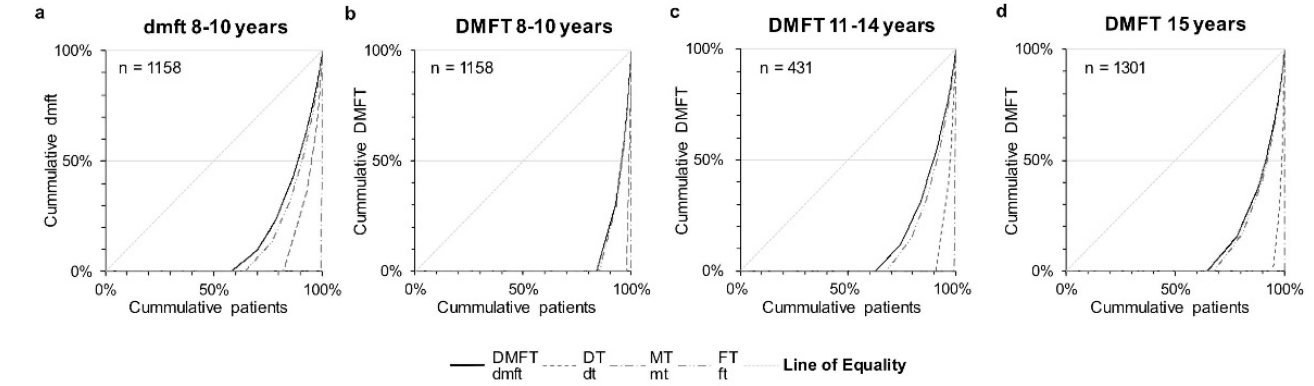
Figure 2. Lorenz curves of the dmft/DMFT values and their components of ( a , b ) 10-year-olds (N = 1158), ( c ) 12-year-olds (N = 431), and ( d ) 15-year-olds (N = 1301). The grey lines indicate the line of equality and 80% of the cumulative proportion of patients with caries burden.